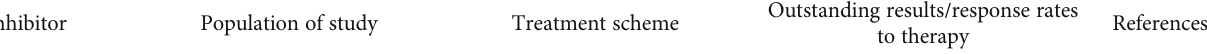
Table 1: Types of PD-1/PD-L1 inhibitors tested in clinical trials mostly evaluated in breast cancer patients with TN